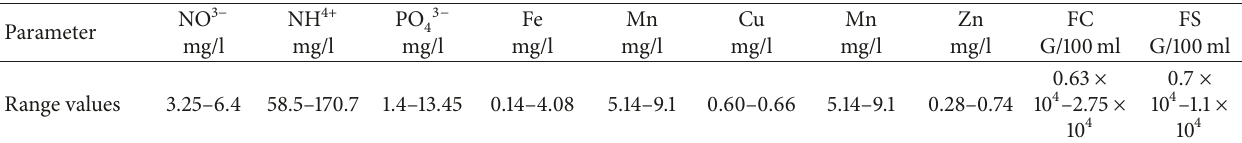
Table 2: Range of nitrogen, phosphorus, heavy metals (ETM), and pathogens contents from 7 upstream to downstream wastewater sampling points in El Gourzi effluent, according to Tamrabet et al.’s [20] study. NO Parameter